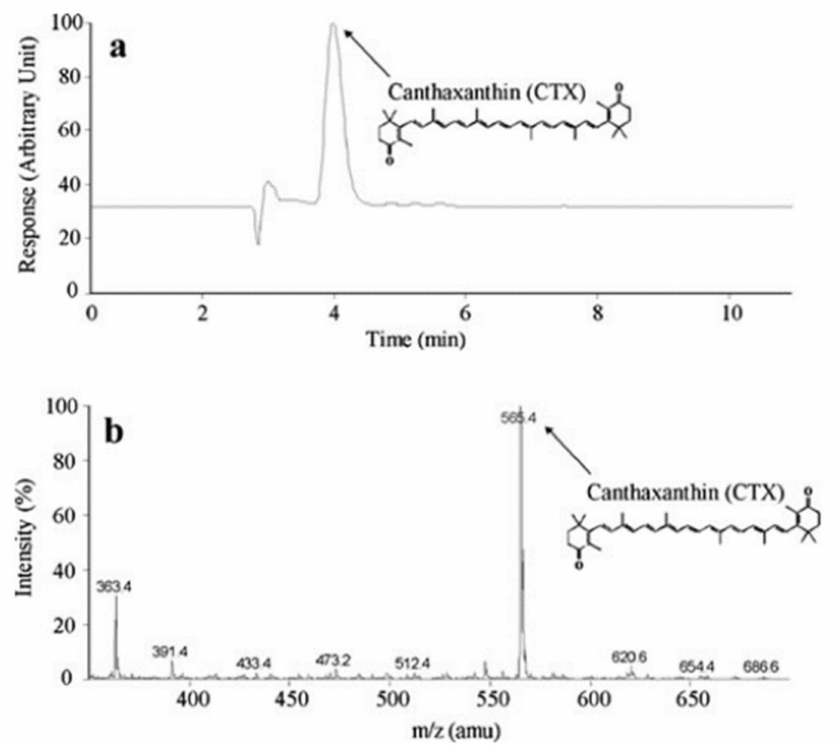
Figure 1. Typical HPLC chromatogram ( a ) and atmospheric pressure chemical ionisation mass spectra performed in positive ion condition ( b ) obtained analysing the biomass produced by D. natronolimnaea